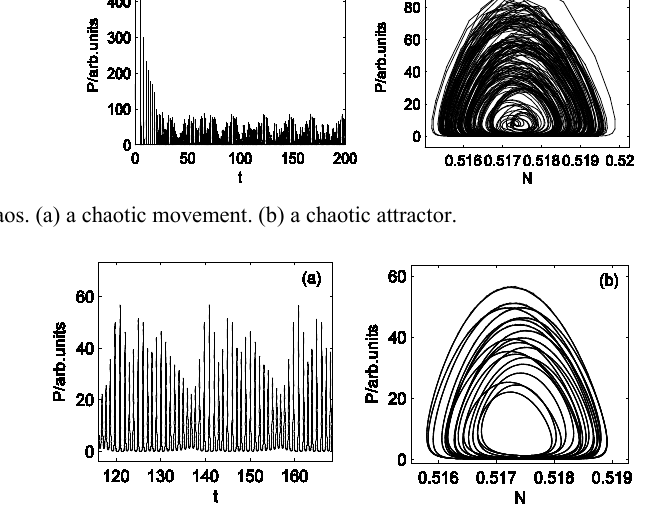
Fig. 11. A quasi-period. (a) a quasi-cycle movement. (b) a quasi-cycle